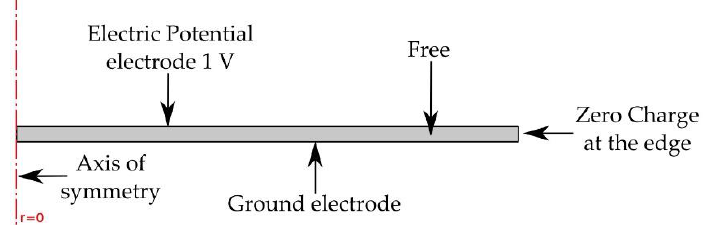
Figure 3. Model for the simulation of the piezoelectric element’s electrical response.